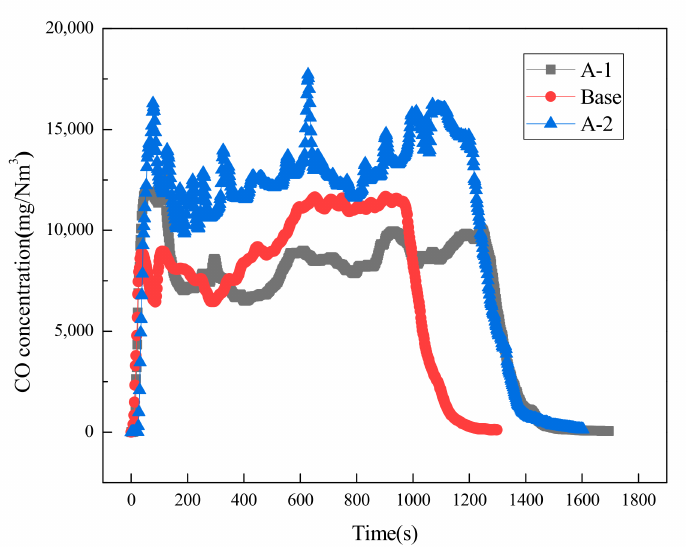
Figure 2. CO emission concentration during sintering at different carbon addition. (The carbon amount: A-1 = 2.6%; Base = 2.8%; A-2 =